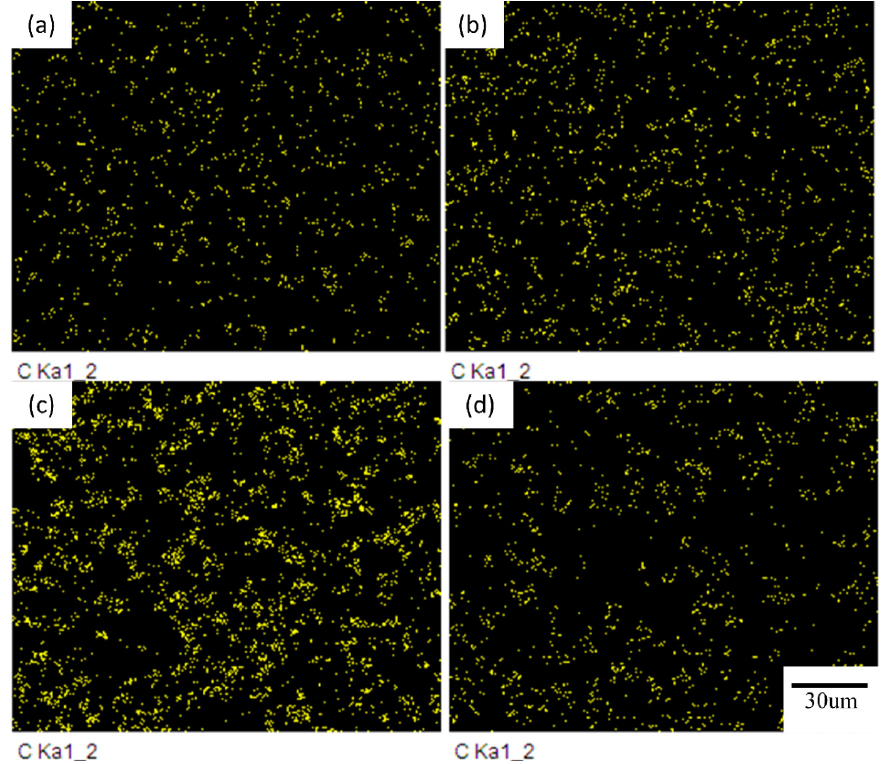
Figure 3. The distribution of carbon elements in the Ni–diamond coating by EDX at different current densities. ( a ) 0.67 A/dm 2 ; ( b ) 1.33 A/dm 2 ; ( c ) 2 A/dm 2 ; ( d ) 4 A/dm 2 .